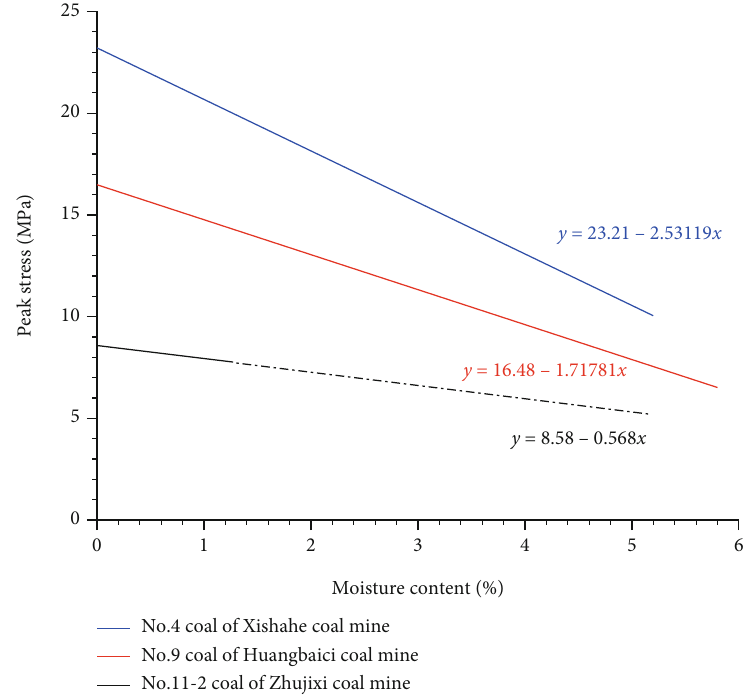
Figure 10: Relationship between peak strain and moisture content of coal